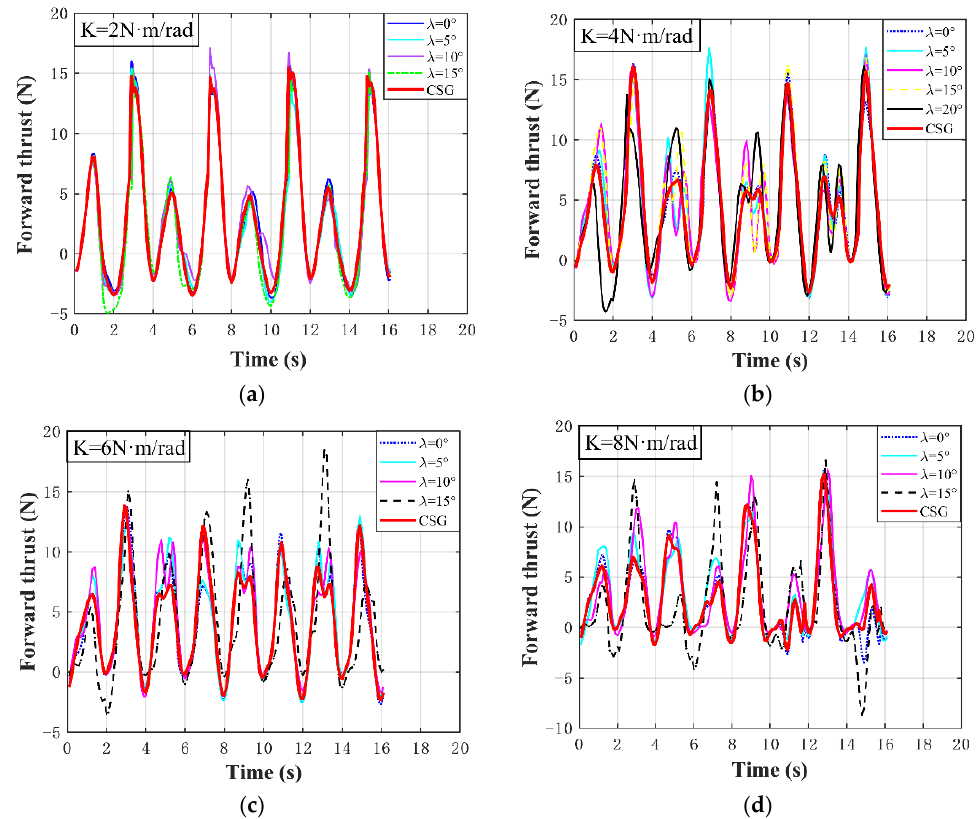
Figure 16. The forward thrusts of the SALL submerged glider under the different K and λ . ( a ) Forward thrust under k = 2; ( b ) forward thrust under k = 4; ( c ) forward thrust under k = 6; and ( d ) forward thrust under k = 8.